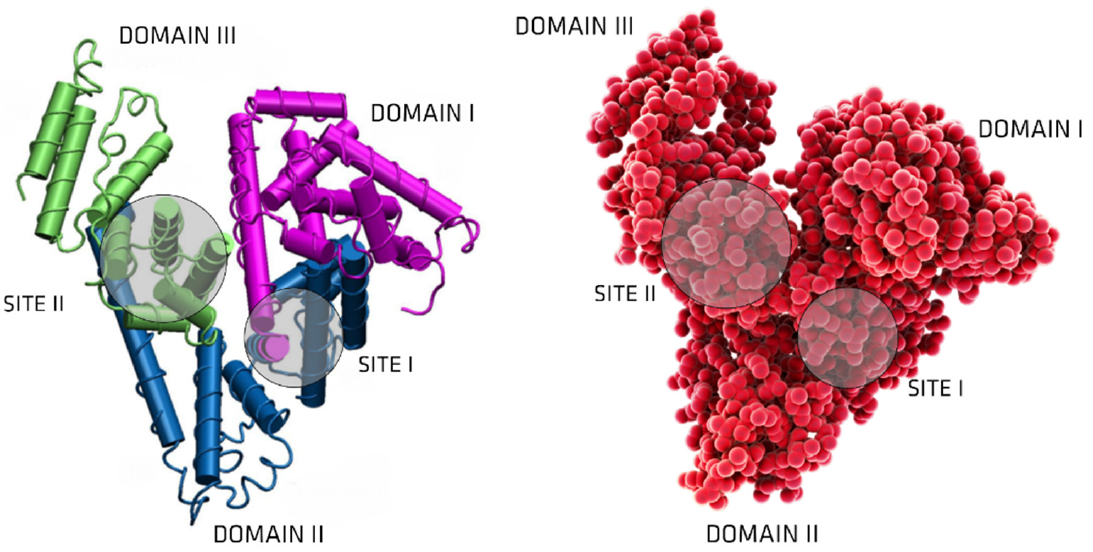
Figure 3. HAS structure. The primary binding sites for anionic, neutral, and cationic ligands are commonly referred to as Sudlow’s sites I and II. In general, bulky heterocyclic anion ligands generally bind to Sudlow’s site I (or the warfarin site), whereas Sudlow’s site II (or the indole-benzodiazepine site) ligands are aromatic and can be either neutral or bear a negative charge located peripherally on the molecule (adapted from [27]).